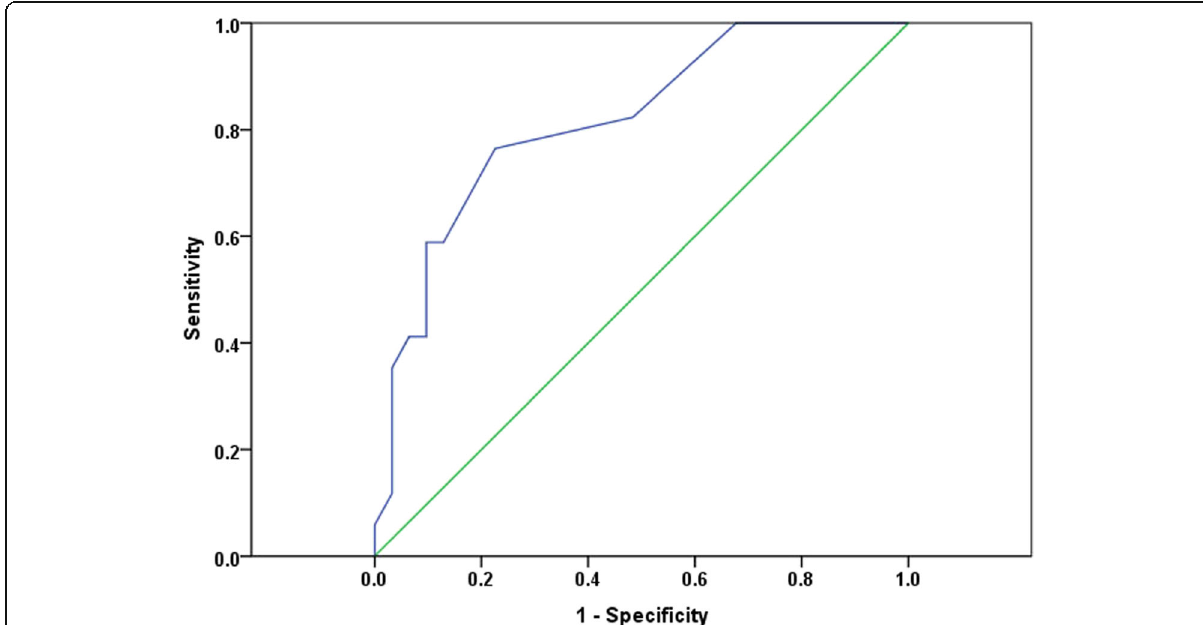
Fig. 1 The receiver operating characteristic curve for the ability of the score from the first chest CT to discriminate patients at high risk for mechanical ventilation/death. Area under the curve 0.817 (95% CI 0.692 to